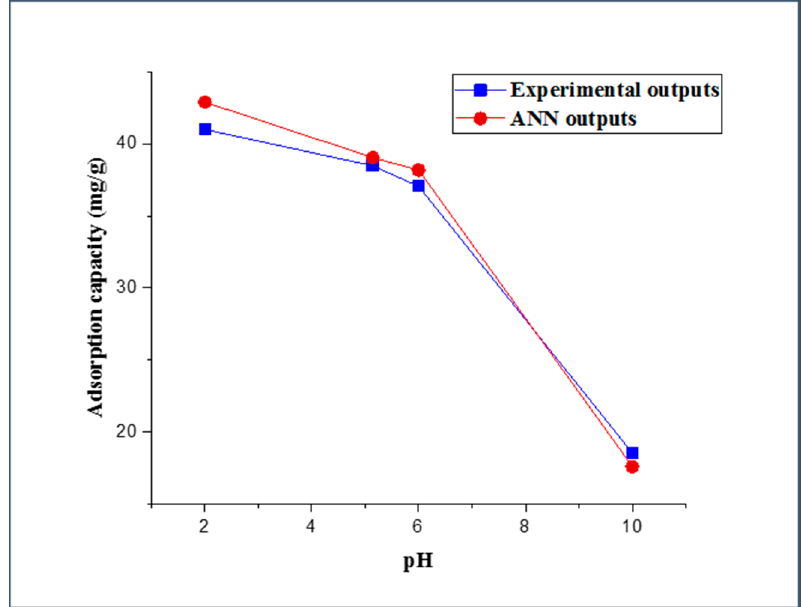
Figure 6. Experimental and FBPNN outputs as a function of pH.